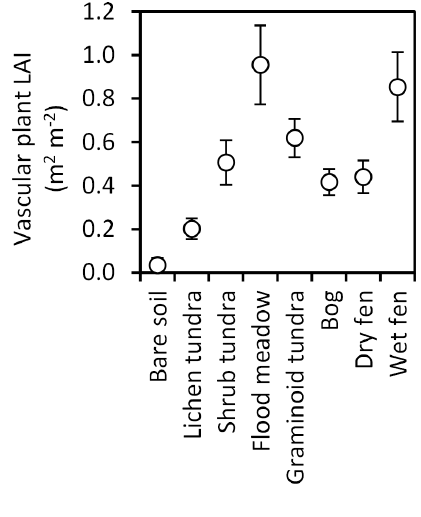
Figure 7. Leaf area index (LAI, mean ± 85% CI) of vascular plants in late July (ca. 360 DD) in the land cover types of Tiksi tundra (arranged in order of increasing soil water